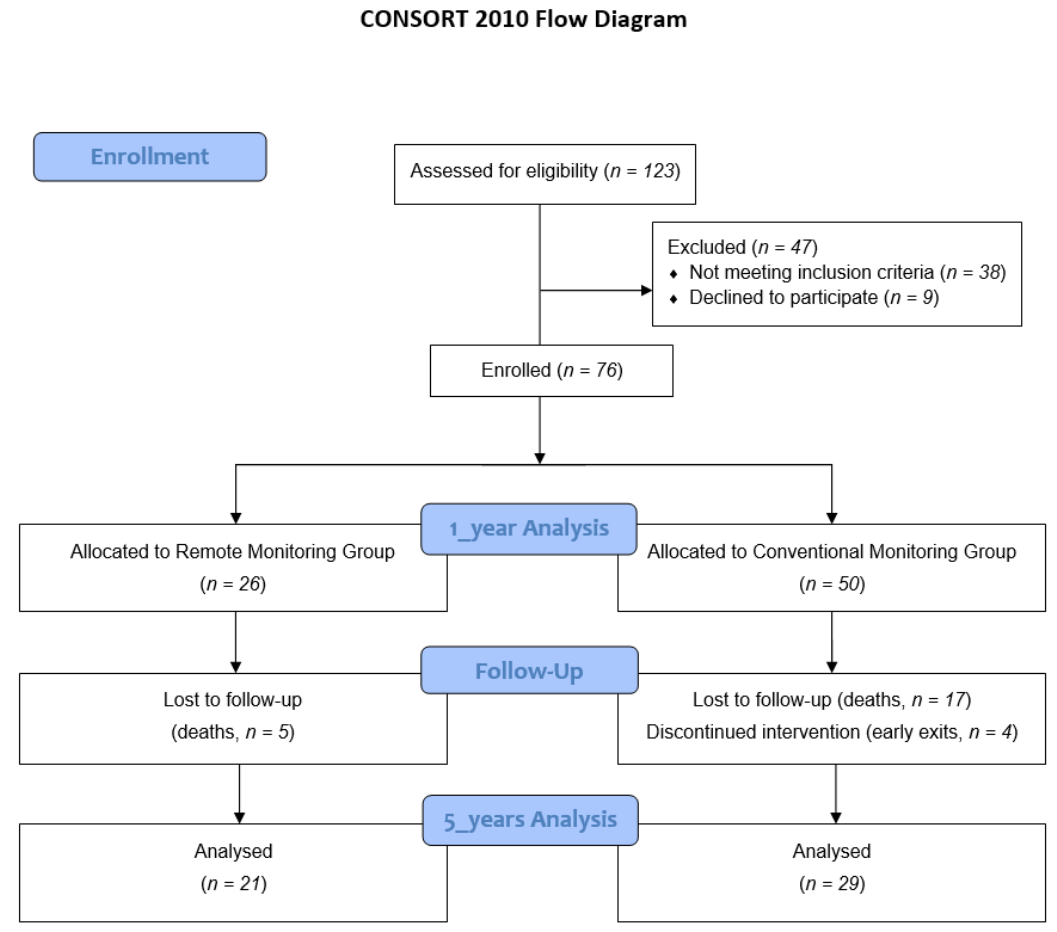
Figure 1. CONSORT flow diagram.